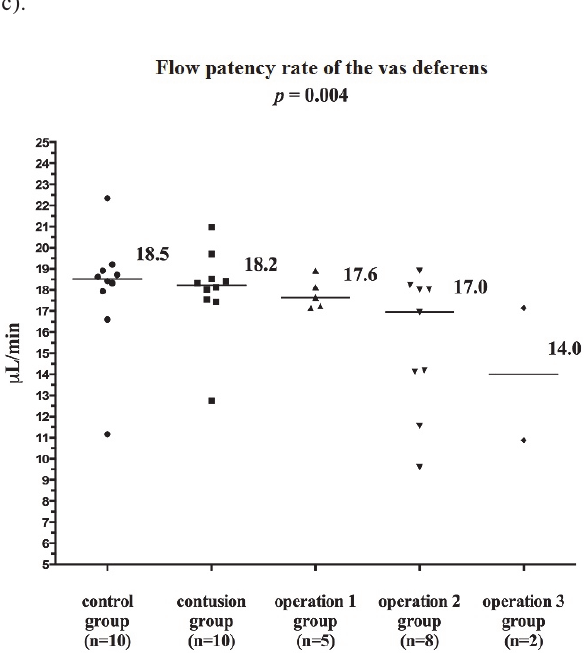
Fig. 2. Flow patency rate of the vas